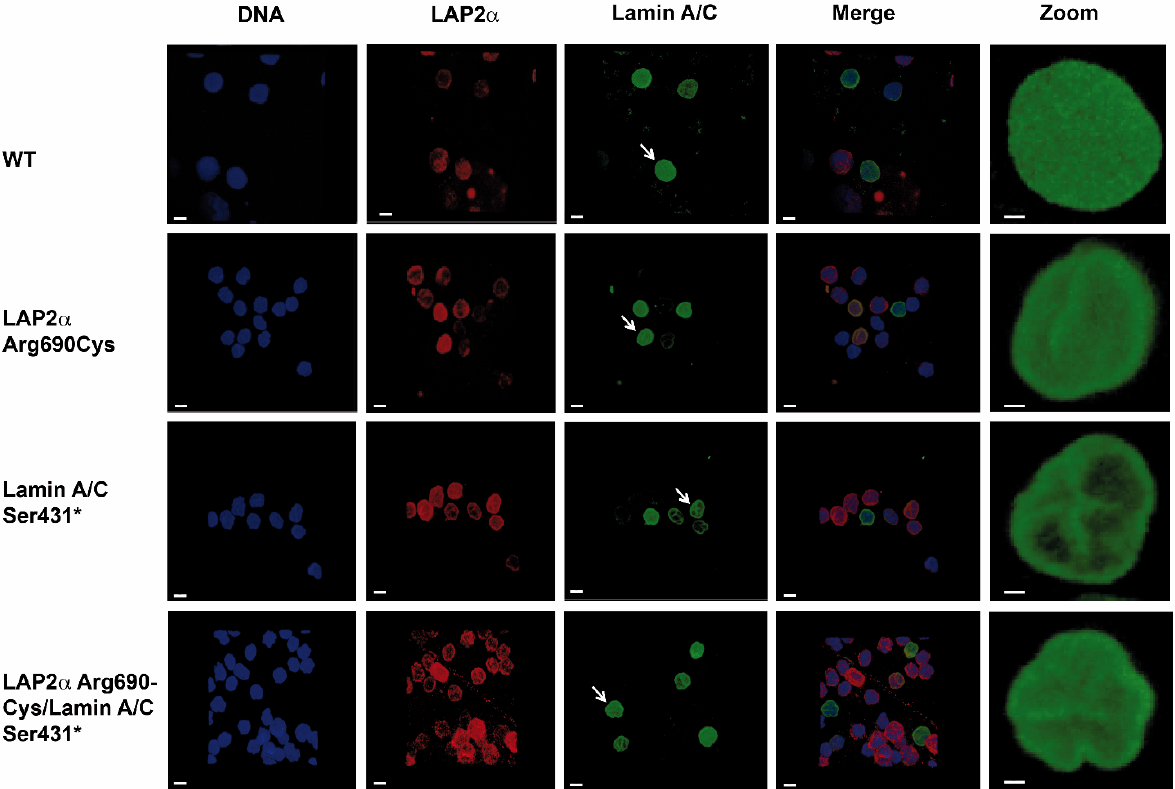
Figure 5. Confocal microscopy showing leukocyte nuclei from family members with different genotypes. Immunofluorescence staining shows blebs, invaginations, and honeycomb images only in nuclei from patients bearing the Lamin AC Ser432* mutation (heterozygous and compound heterzogyous). White arrows indicate the cells magnified in the right column.